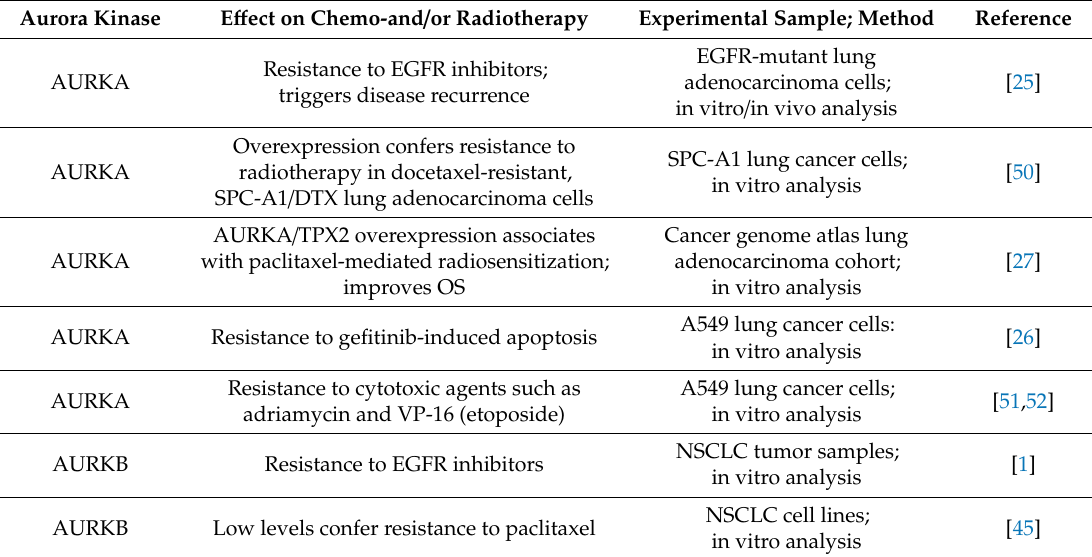
Table 2. Impact of AURKA and AURKB on chemo- and / or radiotherapy in lung cancer. Aurora Kinase E ff ect on Chemo-and / or Radiotherapy Experimental Sample; Method